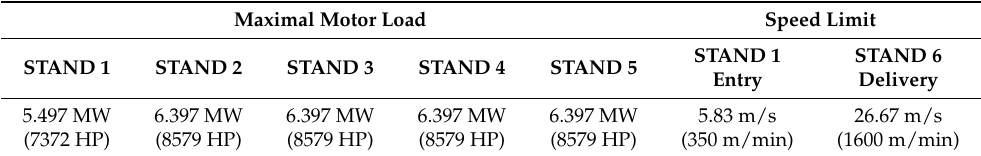
Table 10. Physical limits of the tandem